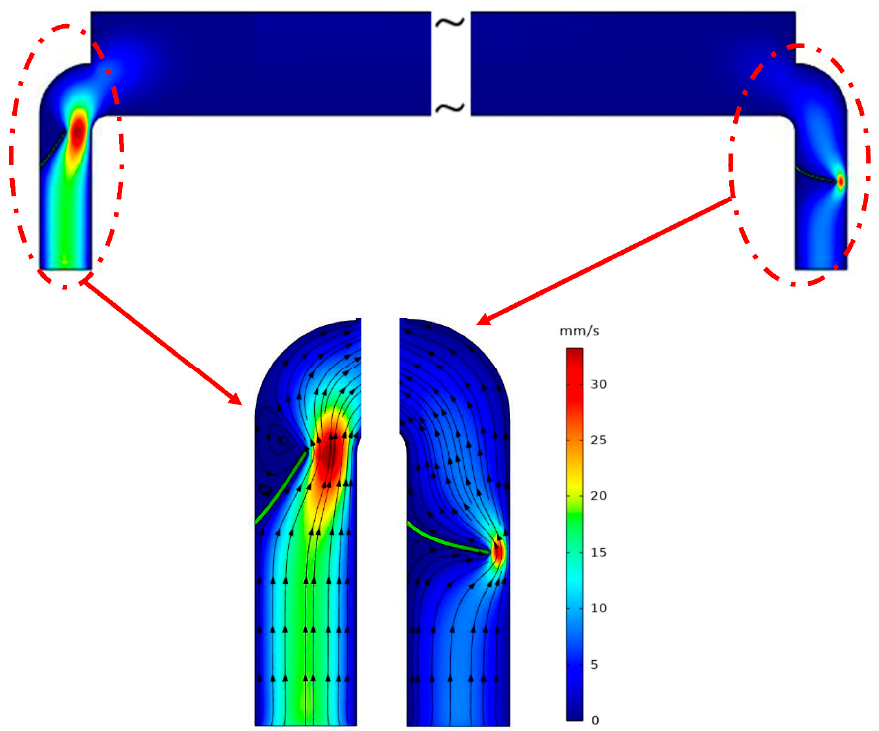
Figure 6. The operation of valve blocking when the piezoelectric component moves upwards ( L p = 5 mm, w = 6 μ m, h p = 130 μ m, V = 400 V)